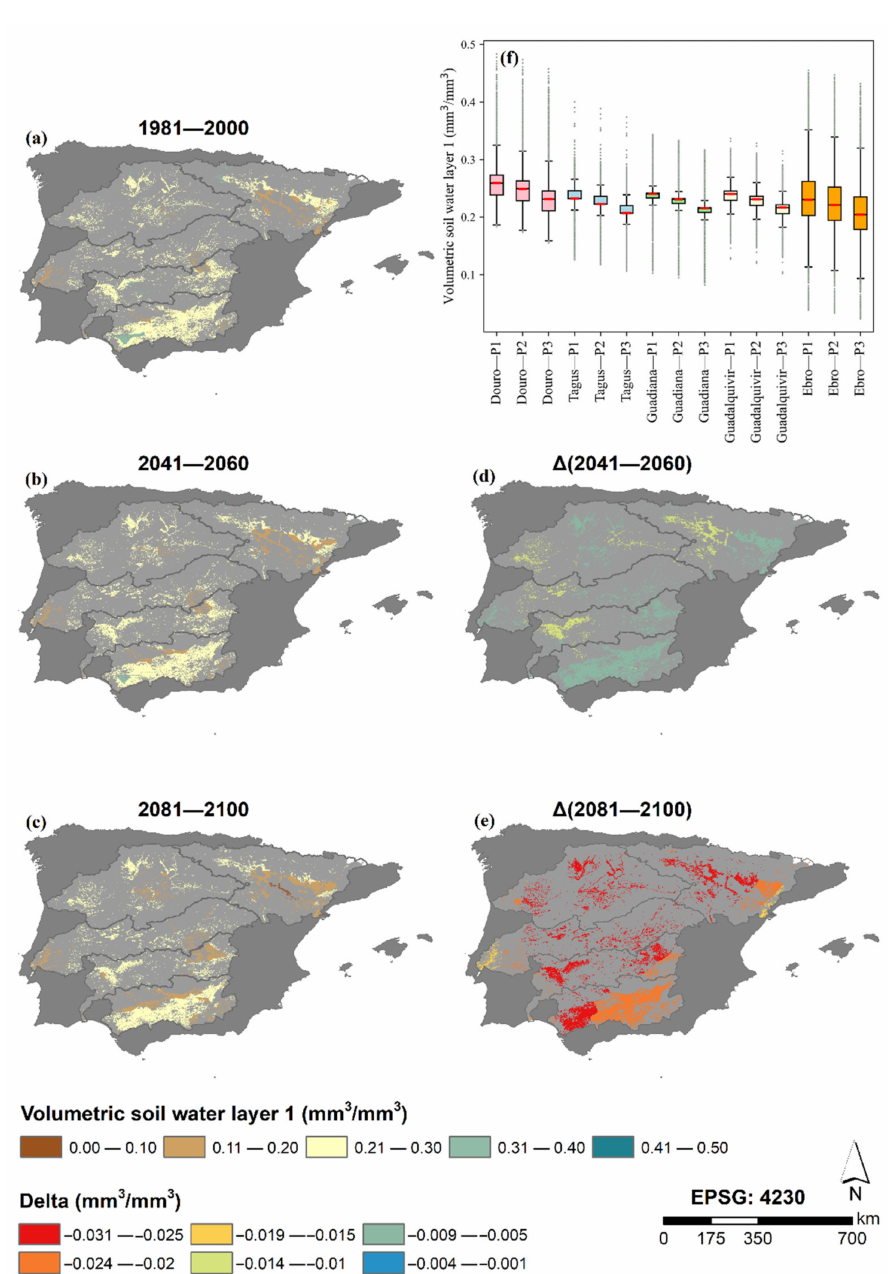
Figure 9. Volumetric soil water in layer 1 (in mm 3 /mm 3 ) in water-dependent areas in the